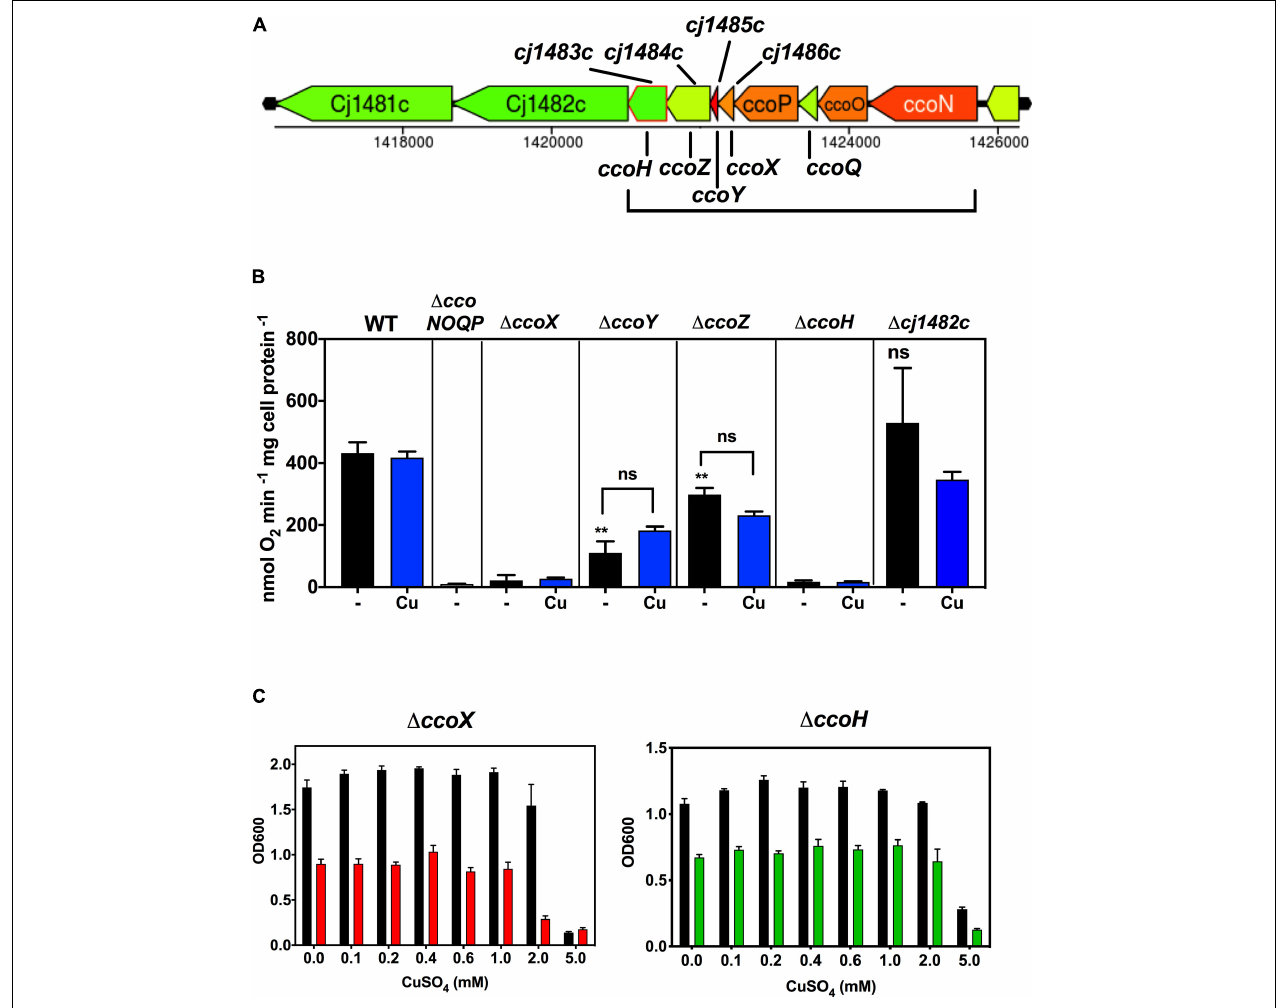
FIGURE 5 | Genes downstream of ccoP are required for Cco activity. (A) Gene organisation at the ccoNOQP locus. Image derived from campyDB (http://xbase.warwick.ac.uk/campydb/) and genes coloured by GC composition as in the legend to Figure 2 . (B) Wildtype, (cid:49) ccoNOQP , (cid:49) ccoX ( cj1486c ), (cid:49) ccoY ( cj1485c ), (cid:49) ccoZ ( cj1484c ), (cid:49) ccoH ( cj1483c ), and (cid:49) cj1482c cells were grown in unsupplemented Mueller-Hinton medium or with copper sulphate added to 0.6 mM, as indicated. Cytochrome c oxidase activity was measured with ascorbate/TMPD as electron donor. Students t -tests were performed to check significance ( p > 0.05, ns; 0.01 > ** p > 0.001). The stars above the black bars represent the statistical significance of comparisons between the unsupplemented mutant and wild-type rates. (C) Growth and copper sensitivity profiles of the (cid:49) ccoX and (cid:49) ccoH strains. In panels (B,C) , the data are the average of triplicate cultures with error bars showing